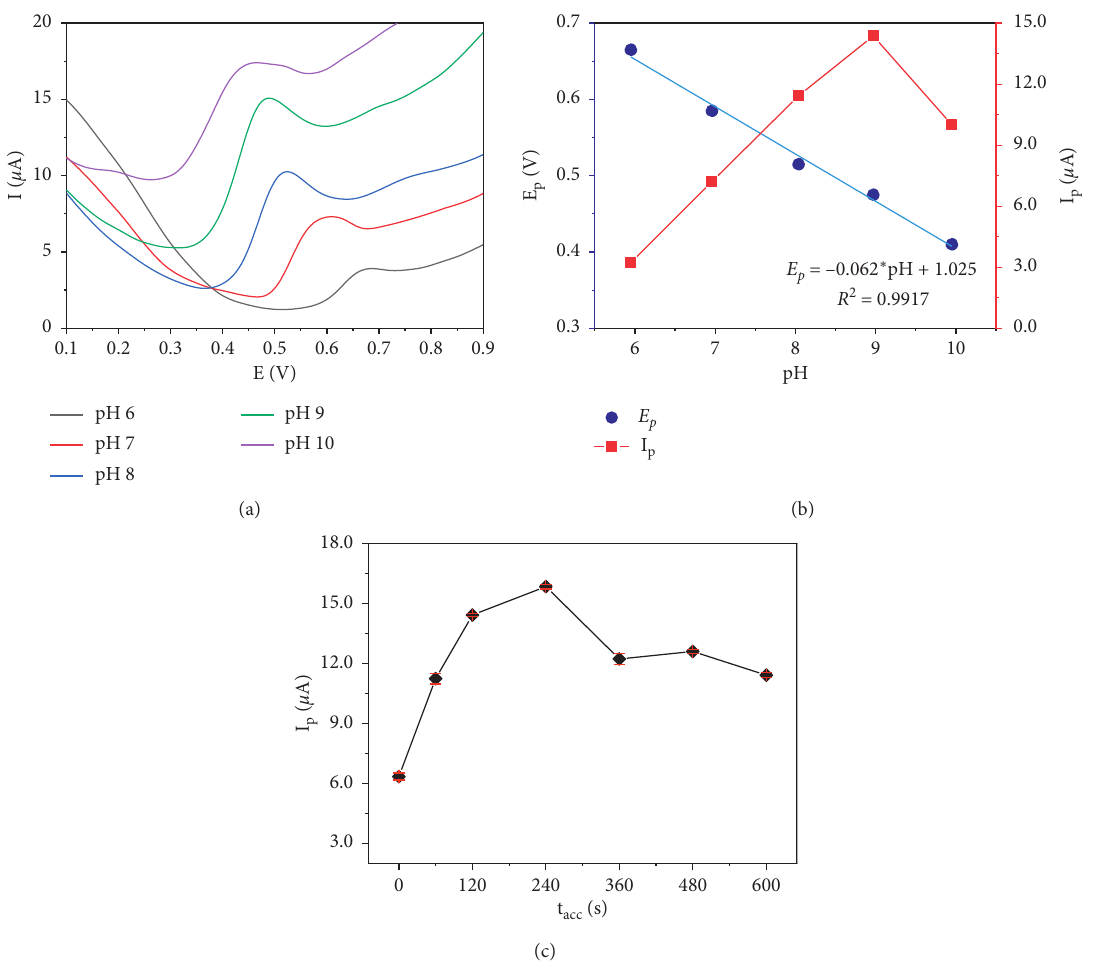
Figure 6: SWVs of RGOnS (with E � -1 V in PBS containing 50 µ M AMX at different pH (a) and plot of the AMX peak potential and peak red current vs. pH (b). Plot of AMX peak current vs. t acc